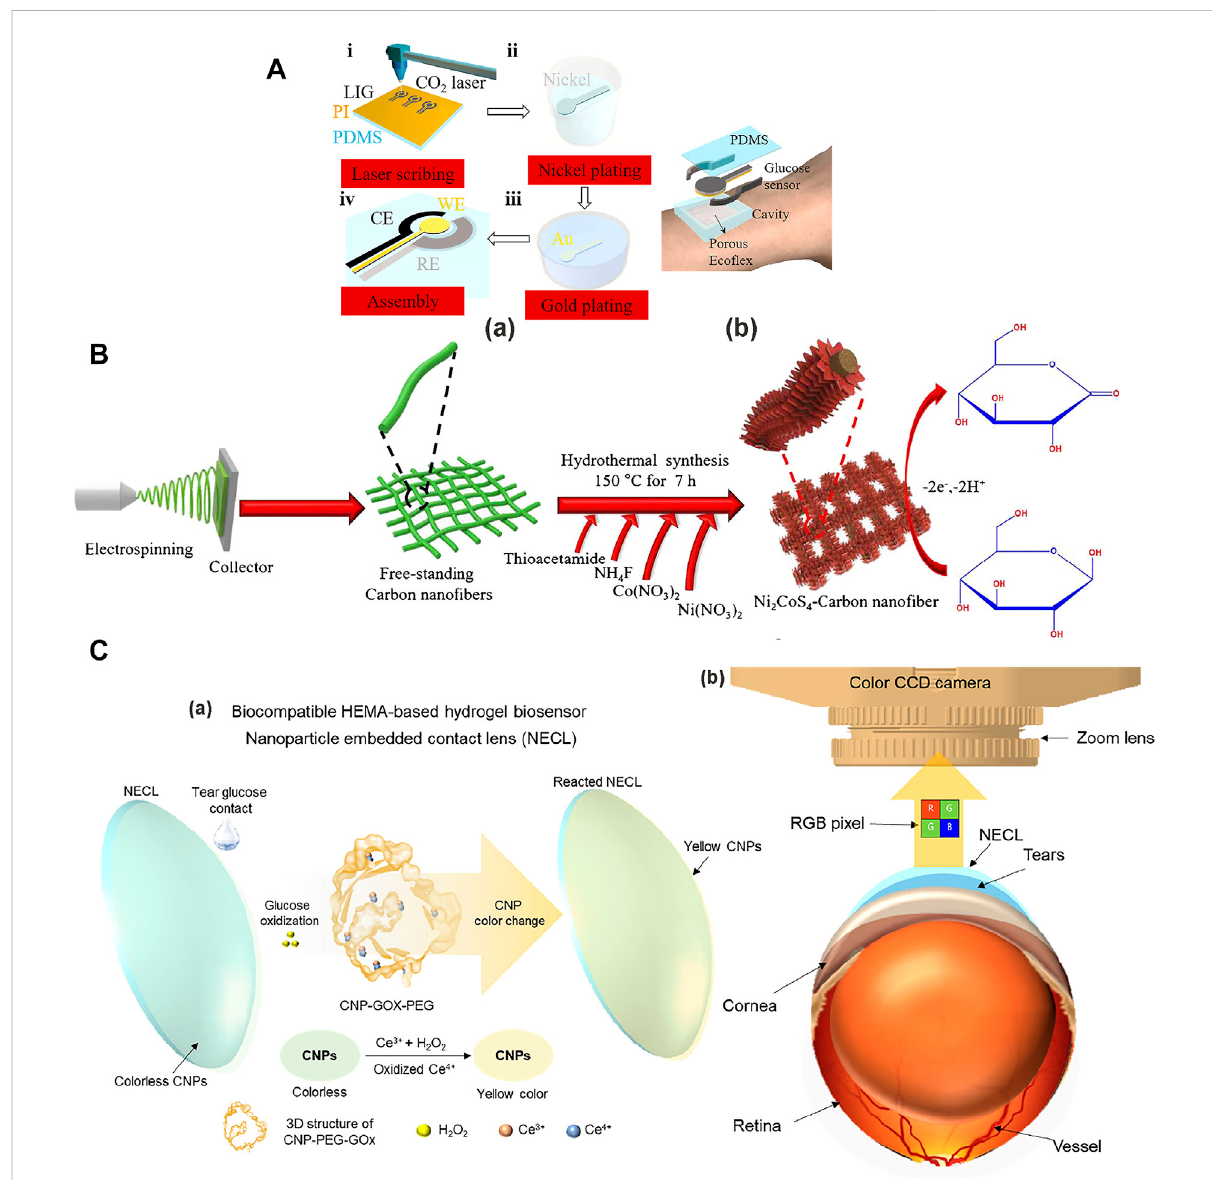
FIGURE 2 Glucose sensors used to detect glucose in sweat, saliva, and tears. (A) Laser-induced graphene non-enzymatic glucose sensor to detect the glucose in the sweat. (a) Fabrication process of the non-enzymatic glucose sensor electrodes. (i) Laser scribing to prepare LIG electrodes. (ii) Ni platingand (iii) Auplating. (iv) Fabricationofworking,reference,andcounterelectrodes. (b) Schematicillustrationofawearableglucosesensor(Zhu J.etal.,2021a). (B) Fabricationprocessofthenon-enzymaticNi 2 CoS 4